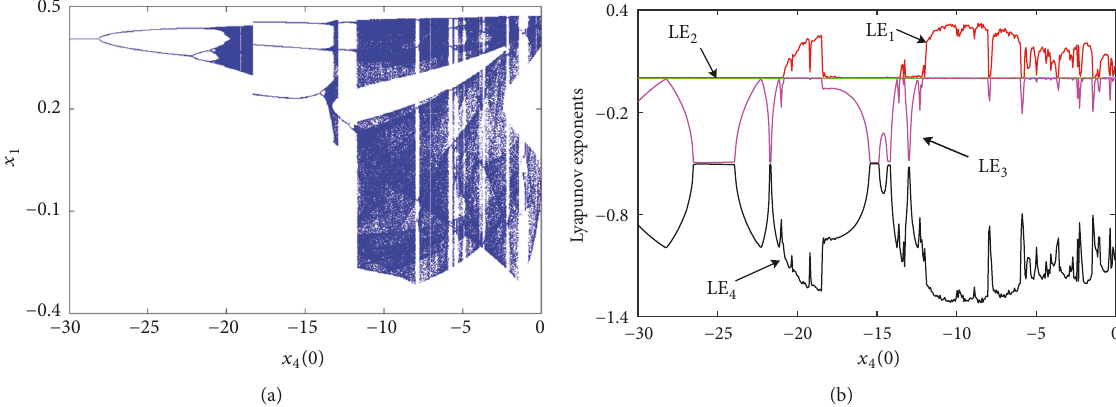
Figure 2: The memristor-initial-dependent dynamics in the range of − 30 < x 4 (0) < 0 with a = 0.7, b = 10, x 1 (0) = 0, x 2 (0) = 10 −6 , and x 3 (0) = 0. (a) Bifurcation diagram of x 1 (t). (b) Finite time Lyapunov exponent